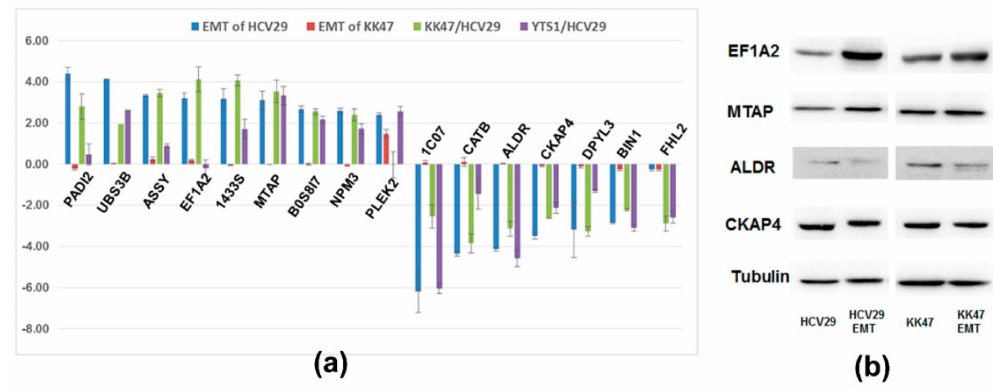
Figure 5. Comparison of proteomes of TGF- β -induced EMT in bladder cells vs. bladder cancer cells. ( a ) The SILAC ratio of proteins in TGF- β -induced EMT bladder cells vs. bladder cancer cells. ( b ) Western blot analysis. PADI2: Protein-arginine deiminase type-2; UBS3B: Ubiquitin-associated and SH3 domain-containing protein B; ASSY: Argininosuccinate synthase; EF1A2: Elongation factor 1-alpha 2; 1433S: 14-3-3 protein sigma; MTAP: S-methyl-5-thioadenosine phosphorylase; B0S8I7: L antigen family member 3; NPM3: Nucleoplasmin-3; PLEK2: Pleckstrin-2; 1C07: HLA class I histocompatibility antigen; CATB: Cathepsin B; ALDR: Aldose reductase; CKAP4: Cytoskeleton-associated protein